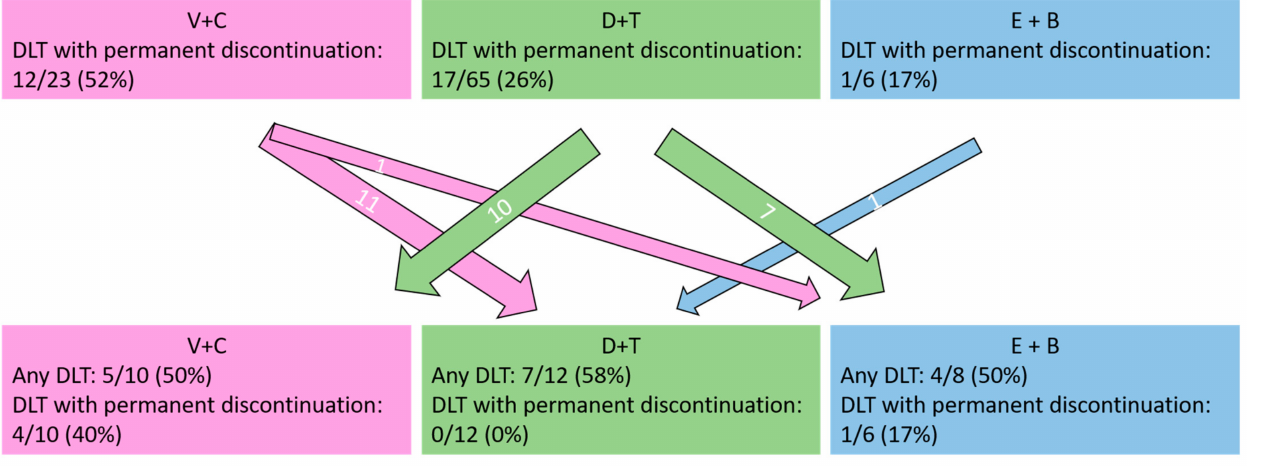
Figure 2. Number of patients treated with the respective BRAF+MEK inhibitor combinations (ve- the first combination was discontinued due to dose-limiting toxicity (DLT). Numbers in the arrows represent the number of patients switching to the respective second BRAFi+MEKi